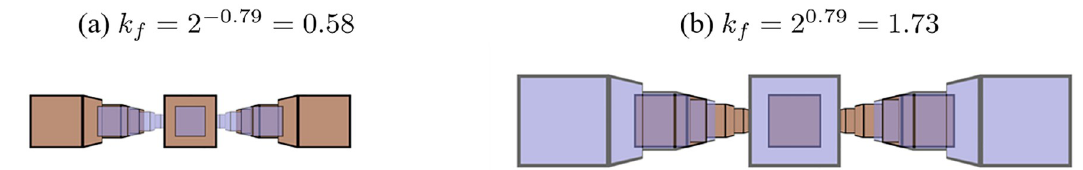
= 1.73). Solid lines represent the eccentricity-disparity in the original f